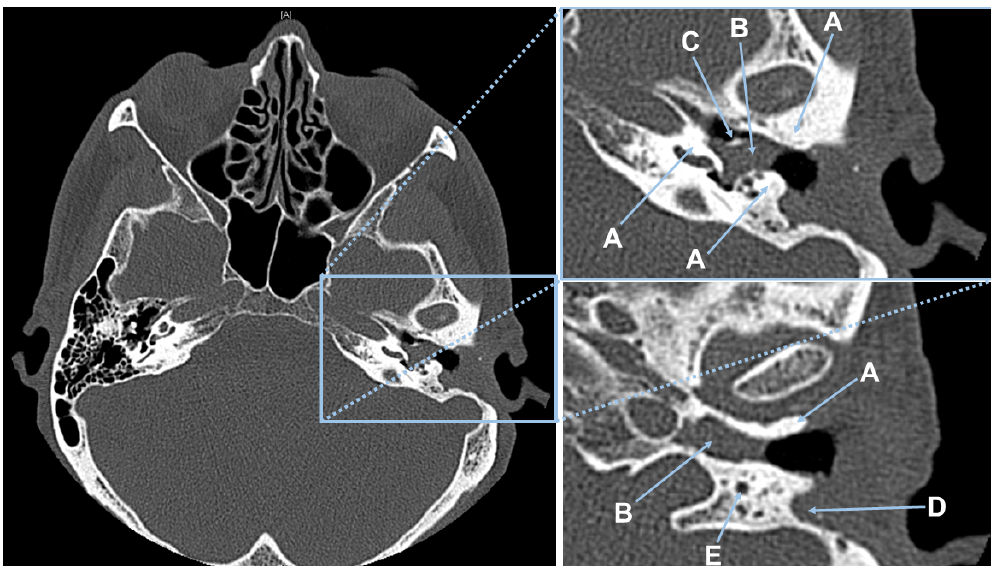
Figure 3. CT scan of Patient #1. ( Left ) Showing the complete CT slice. ( Top right ) Magnified CT-slice showing the patient’s left middle ear anatomy. In this view, (A) bone, (B) cholesteatoma, and (C) the handle of malleus covered with cholesteatoma. ( Bottom right ) Magnification of a 2nd CT-slice with (A) bone, (B) cholesteatoma, (D) connective tissue in the pre-surgical removed canal wall, and (E) the nervus facialis embedded in bone.